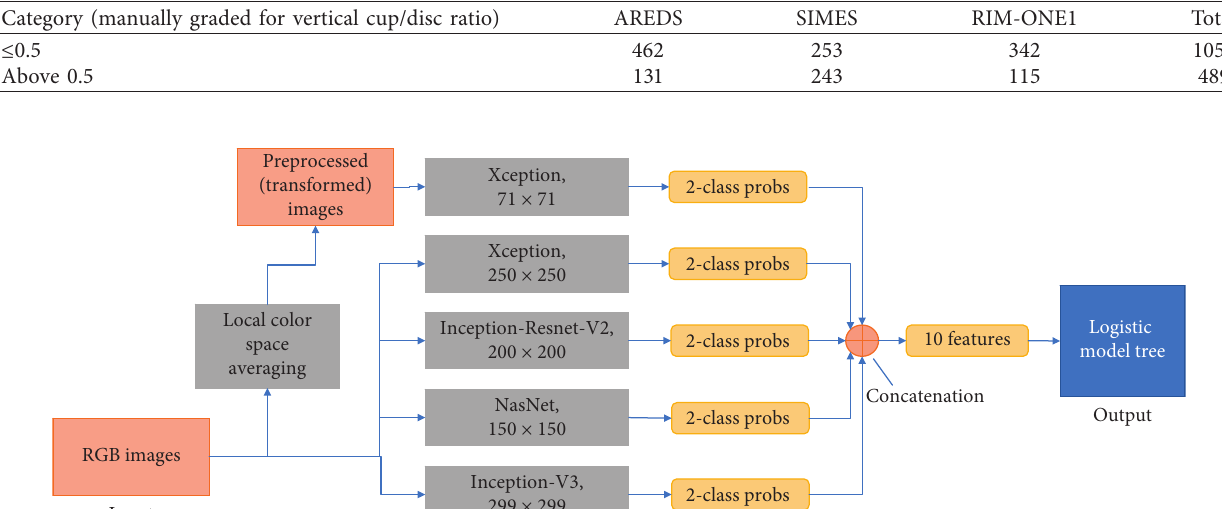
Figure 2: (a) A 30-degree fundus image and (b) the automatically cropped optic disc region. (c) Another cropped example that is preprocessed to obtain the (d) final image. Table 1: Number of images taken from AREDS, SIMES, and RIM-ONE1. The table shows the various groups to which the images belong based on their graded cup/disc ratios.